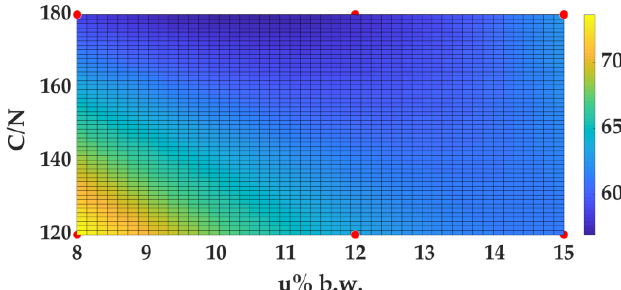
Figure 15. Response surface for diesel oil removal by microcosms with C/N = 120 and C/N = 180 at t = 112 days.